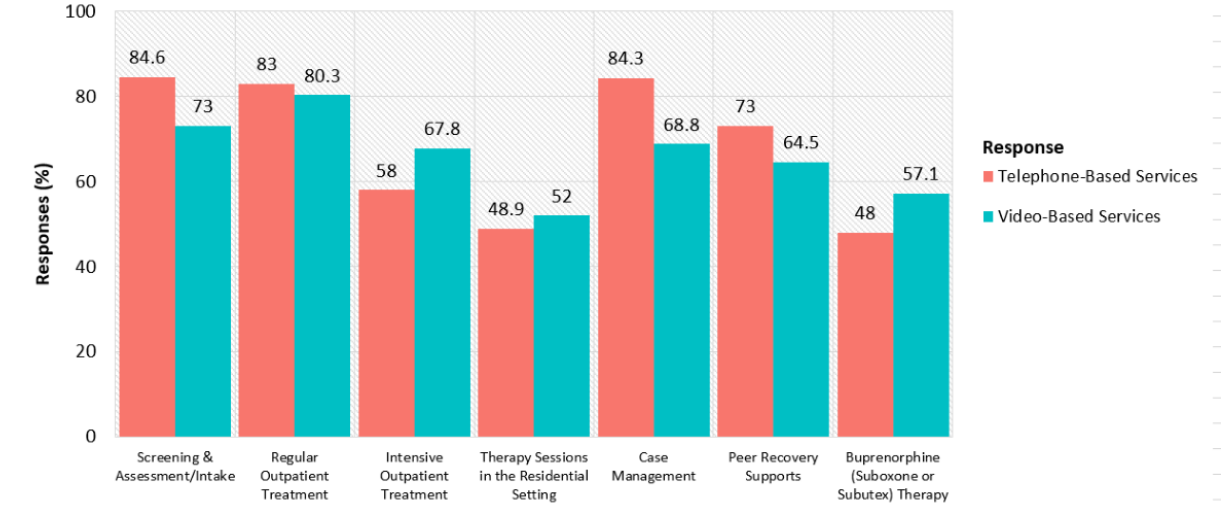
Figure 1. Rates of use of different telehealth